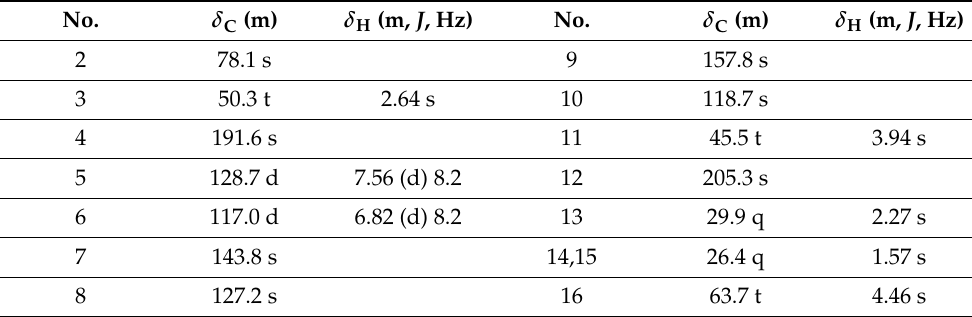
Table 2. 1 H NMR and 13 C NMR data for compound 4 (in CDCl 3 , 500 and 125 MHz).